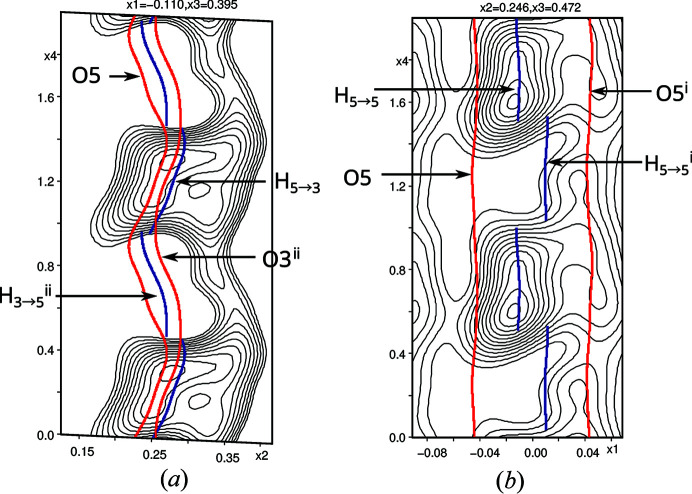
Superspace sections centred around (a) H5→3 and (b) H5→5 with 2 Å width. The refined positional displacements are indicated by red (O) and blue (H) lines. Symmetry codes: (i) −x
1, x
2, 1− x
3, x
4 − x
3; (ii) −x
1 − ½, x
2 + ½, −x
3, x
4 − x
3.